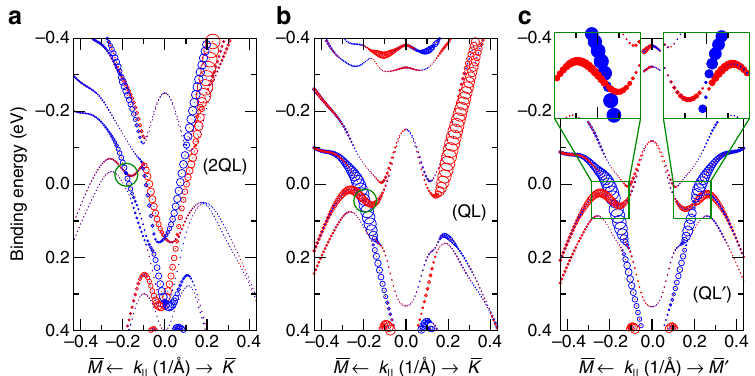
Figure 2 | Spin-resolved DFT surface electronic structure calculations. Band structure along M G K of slabs of Bi 1 Te 1 terminated by ( a ) 2QLs and ( b , c ) 1QL. The size of the symbols corresponds to the spin polarization in the first four layers of a slab, the colour (red/blue) indicates the orientation of the spins with respect to a direction perpendicular to the momentum and surface normal. The green circle marks the Dirac cone of the TCI. In c (QL 0 ), the symmetry has been broken by strain along [1100] direction, such that G M 0 is no longer a high-symmetry line and a gap opening can be observed (see inset).